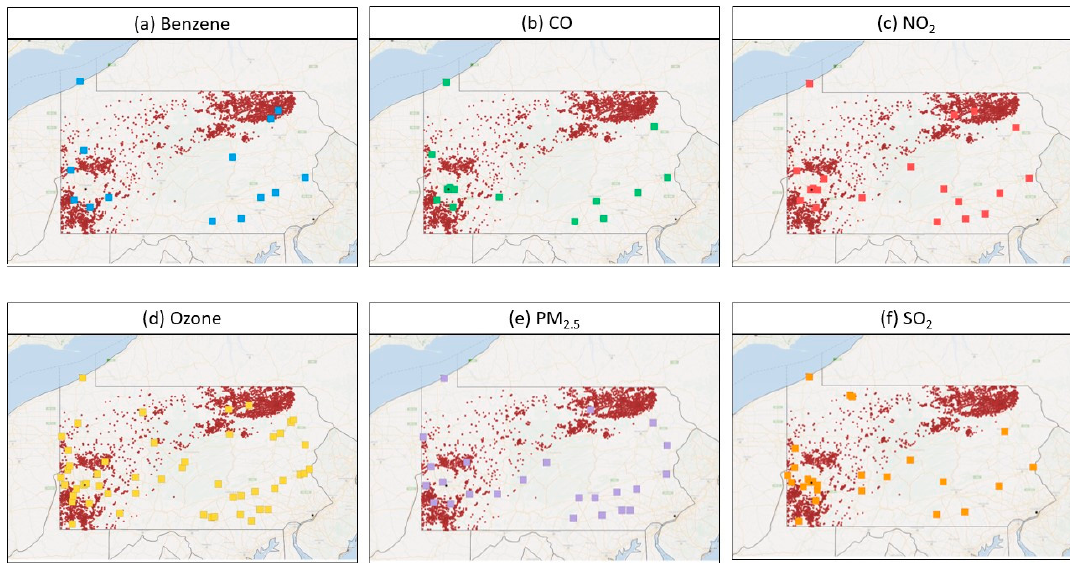
Figure 4. Location of unconventional gas wells (red circles) in Pennsylvania in any phase of development between 2011 and 2015, and monitoring sites (colored squares) where ambient air samples of ( a ) benzene, ( b ) CO, ( c ) NO 2 , ( d ) O 3 , ( e ) PM 2.5 and ( f ) SO 2 were collected, and which served as simulated study subject residences.